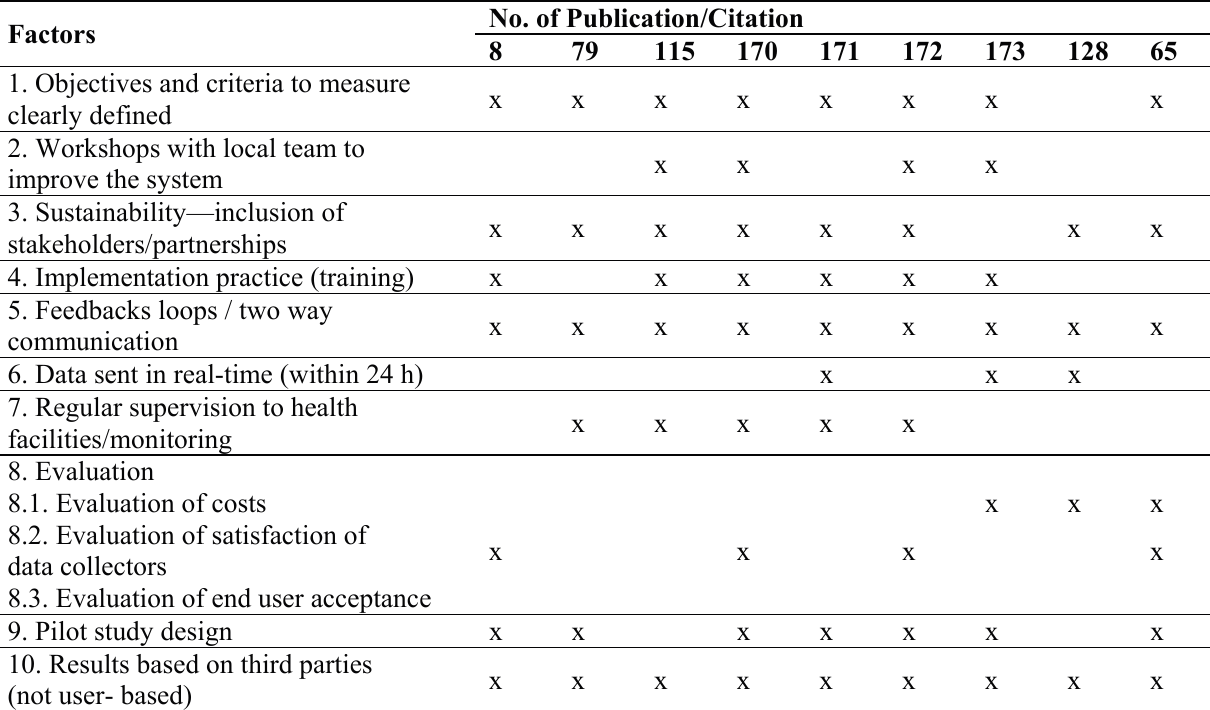
Table 4. Assessment of methodological rigour of